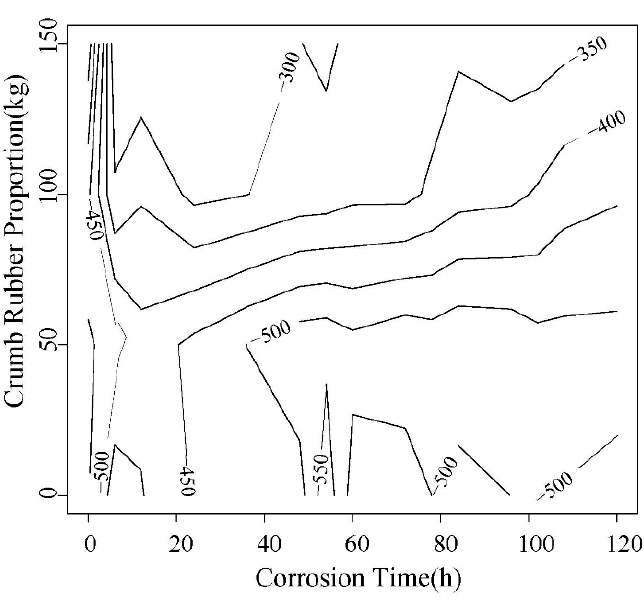
Figure 6. Change trend of the corrosion potential value of steel bar in 0.45 water-cement ratio.